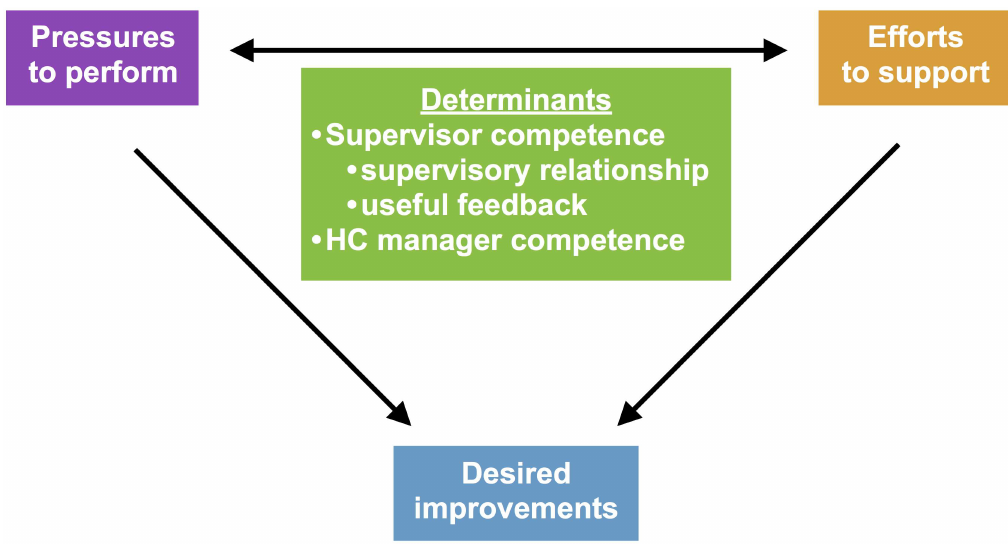
Fig 1. Determinants of the outcome of pressuresto perform and efforts to support.